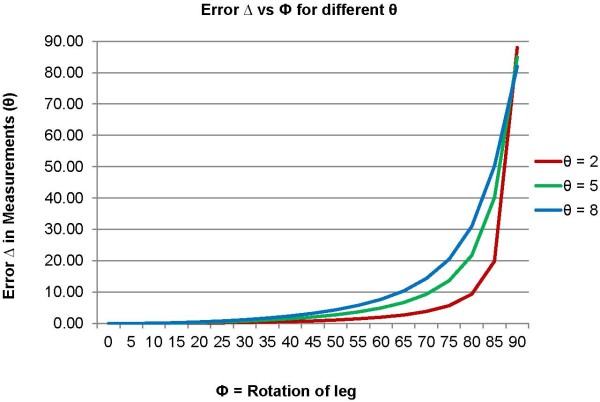
Variation of angular error(Δ) with knee rotationangle Ф for threedifferent angular measurements (θ)of tibial component angle.